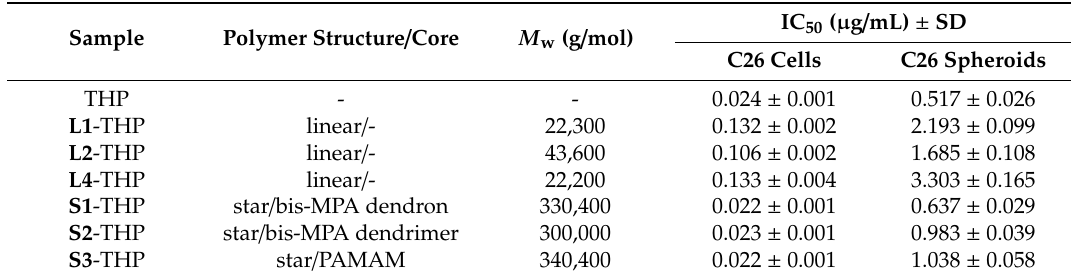
Table 4. In vitro cytotoxicity of THP-polymer conjugates against monolayer colon carcinoma cells C26 and C26 spheroids detected by MTT assay.